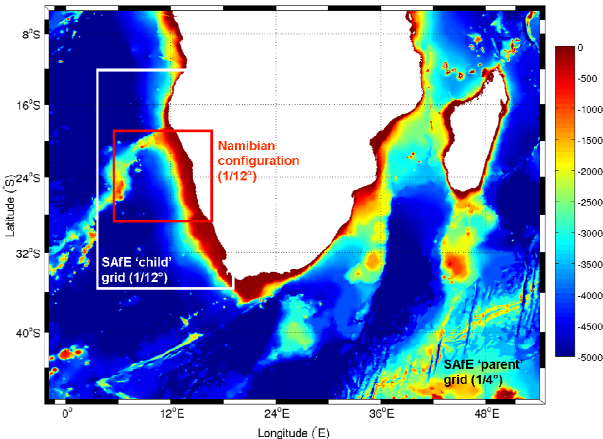
Figure 1. Bathymetry (in meters) from 1’ GEBCO. Domain of the Southern Africa 1616 Fig. 1. Bathymetry (in meters) from 1 0 GEBCO. Domain of the Experiment (SAfE "parent" grid; 2.5°W - 54.75°E and 4.8°S - 46.75°S, 1/4°). The high 1617 Southern Africa Experiment (SAfE “parent” grid; 2.5 ◦ W–54.75 ◦ E resolution domain (SAfE "child" grid; 3.9°E - 19.8°E and 12.1°S - 35.6°S, 1/12°) is 1618 and 4.8–46.75 ◦ S, 1/4 ◦ ). The high-resolution domain (SAfE “child” represented by the domain within the white rectangle, and the Namibian configuration (5°E - 1619 grid; 3.9–19.8 ◦ E and 12.1–35.6 ◦ S, 1/12 ◦ ) is represented by the do- 17°E and 19°S - 28.5°S, 1/12°) developed and validated in this study is depicted by the 1620 main within the white rectangle, and the Namibian configuration domain within the red rectangle. 1621 (5–17 ◦ E and 19–28.5 ◦ S, 1/12 ◦ ) developed and validated in this study is depicted by the domain within the red